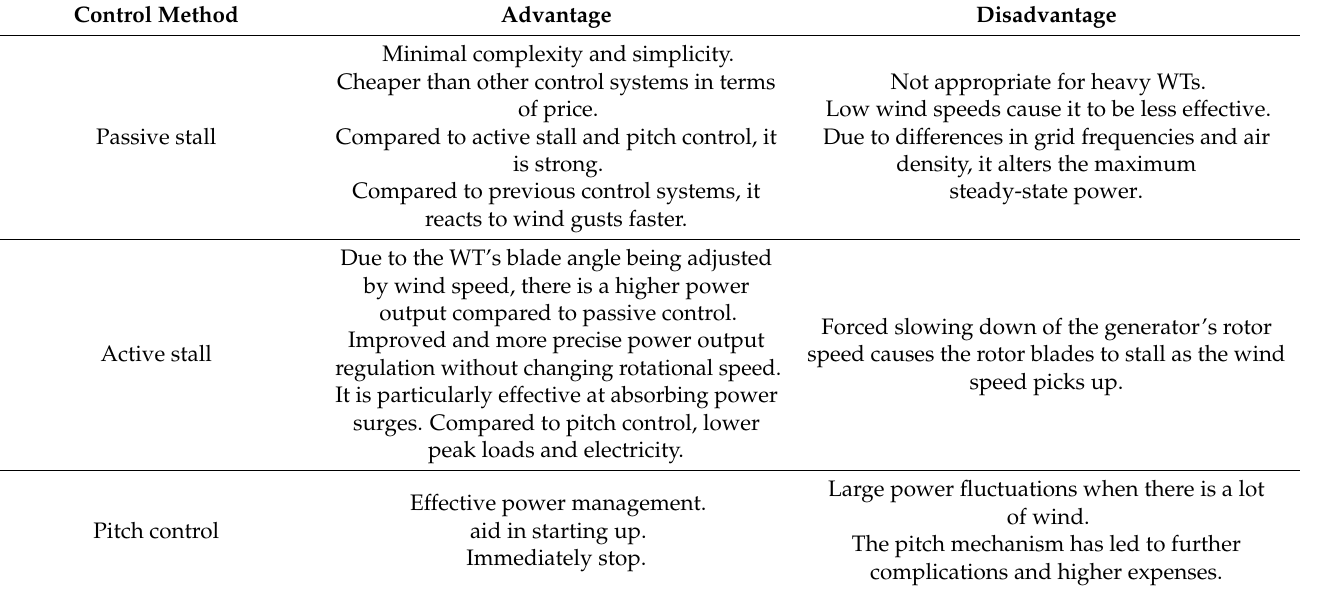
Table 3. Summary of passive, active, and pitch control of WTs